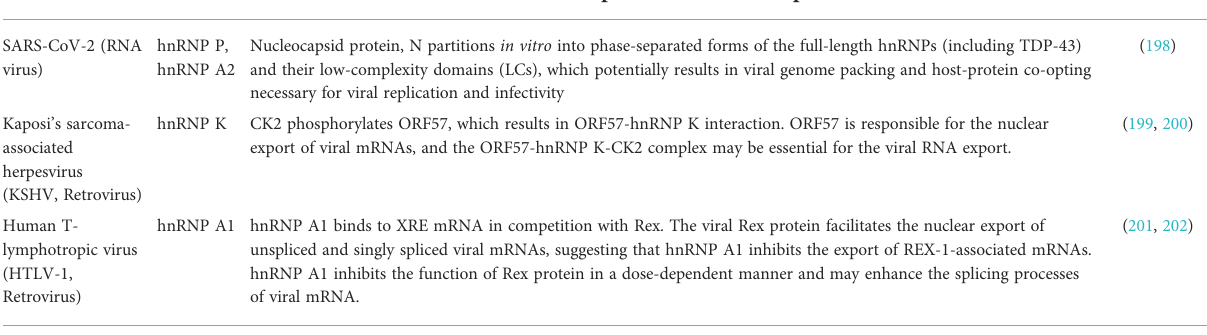
TABLE 5 hnRNPs participate in viral RNA traf fi cking and packaging of RNA viruses and Retroviruses. Viruses hnRNPs Functional implications in viral